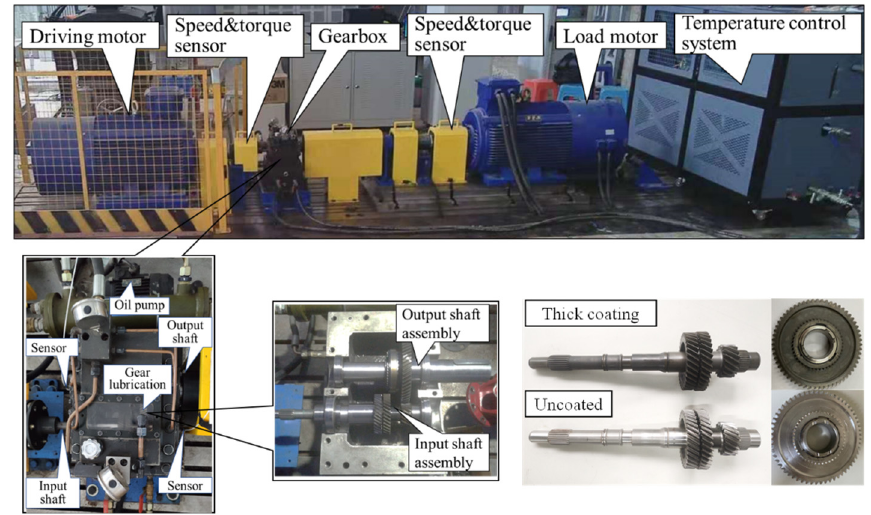
Figure 5. Gear transmission performance test bench.